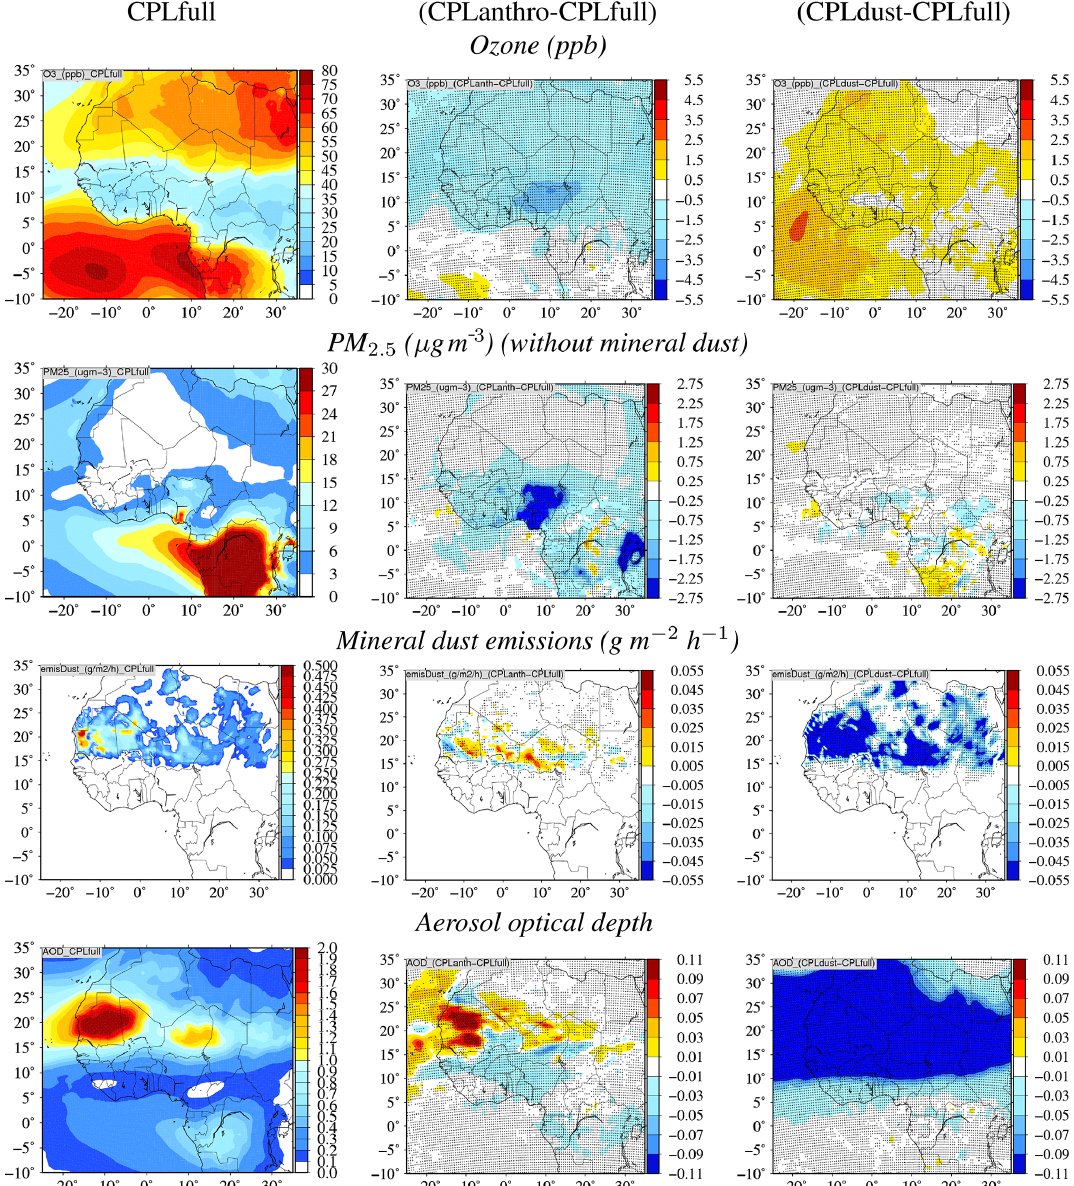
Figure 9. Left column (from top to bottom): maps of the monthly mean of ozone (ppb), PM 2 . 5 (µgm − 3 ) (without mineral dust), mineral dust emissions (gm − 2 h − 1 ) and aerosol optical depth for July 2016. Middle column: maps of the monthly mean of daily averaged differences between CPLanthro and CPLfull for the same variables as the left row. Right row: maps of the monthly mean of daily averaged differences between CPLdust and CPLfull for the same variables as the left row. The tiny crosses on the map indicate where the difference was found to be